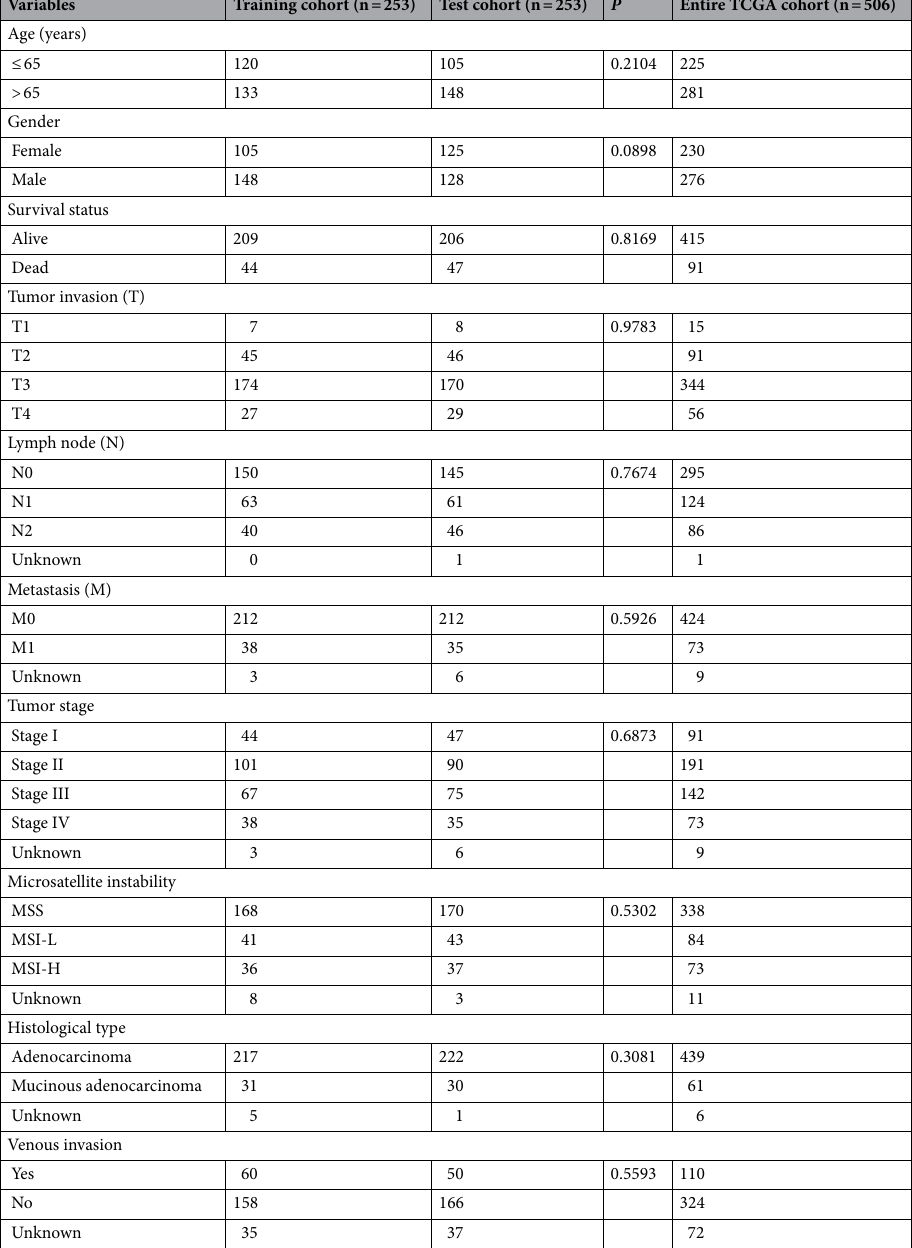
Table 1. Clinical features of the patients with CRC in each